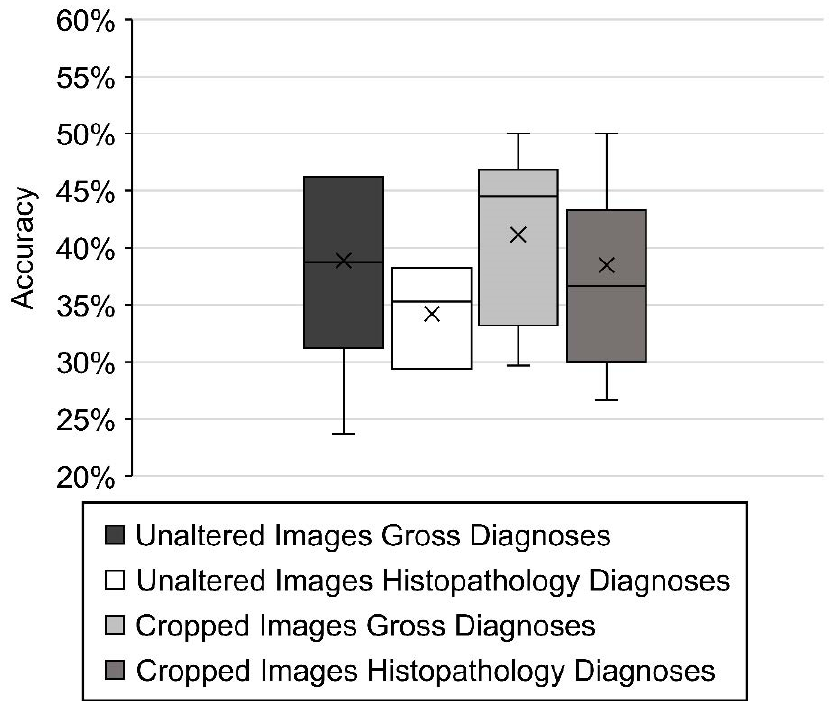
Figure 4. Box plot of image classification best model accuracies using the automated ML feature of Microsoft Azure for right lateral lung cattle images using the following data sets: unaltered images and their respective gross diagnoses, unaltered images and their respective histology diagnoses, cropped images and their respective gross diagnoses, and cropped images and their histology diagnosis. The variation is the representation of the epoch level within training. The × within box represents the mean, while the line represents the average. Table 2. Performance estimates resulting from the image classification models using the automated ML feature of Microsoft Azure for right lateral lung cattle images using the following data sets: unaltered images and their respective gross diagnoses, unaltered images and their respective histology diagnoses, cropped images and their respective gross diagnoses, and cropped images and their histology